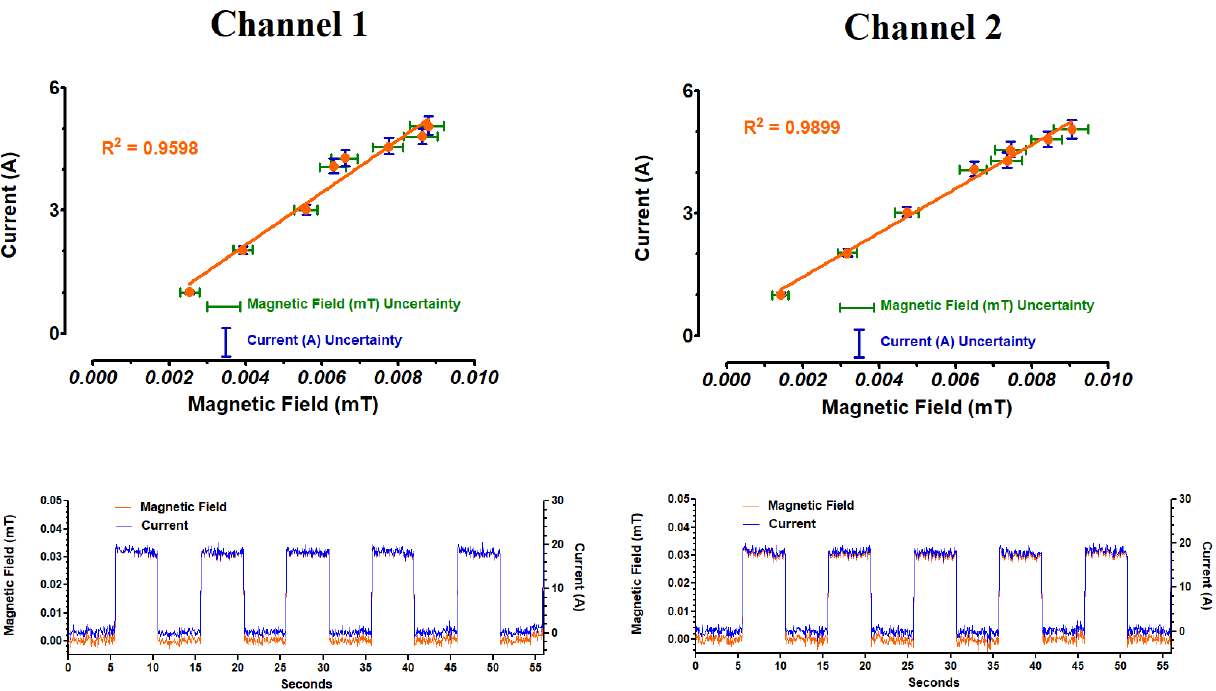
Figure 2. Relationship between magnetic field (mT) and current (A). Upper panels illustrate the linearity of the calibration curves for both channels, and the bottom panels show the actual magnetic fields and currents established from the first five puffs of the ECIG aerosol generator (five-second puffs with a five-second interval between puffs) for both channels.